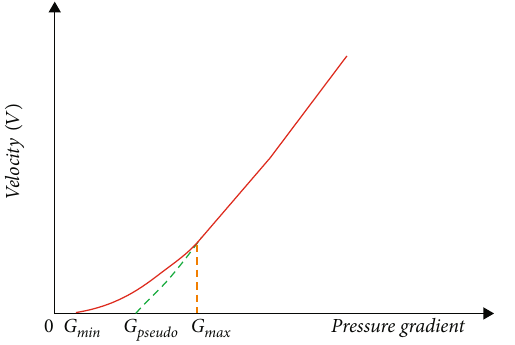
Figure 1: Schematic diagram of the typical non-Darcy fl ow